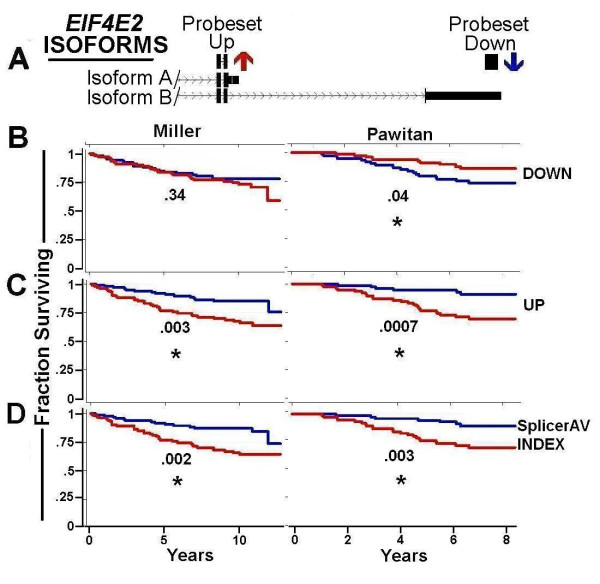
EIF4E2 probesets are associated with breast cancer survival. Panel A. Schematic representation of EIF4E2 isoforms A and B, with region interrogated by probesets shown as Up (red arrow), and Down (blue arrow). For panels B, C, and D, the fraction of patients surviving in each cohort (vertical axis) is shown over time in years (horizontal axis) as a function of individual probeset expression or SplicerAV index. Survival of patients in the top (red line) and bottom (blue line) 50th percentile are plotted by individual probeset expression (B, C) and the SplicerAV index (D) within the Miller (left) and Pawitan (right) cohorts. Results of two-tailed logrank tests of survival are shown, with asterisks indicating significance at the .05 level.